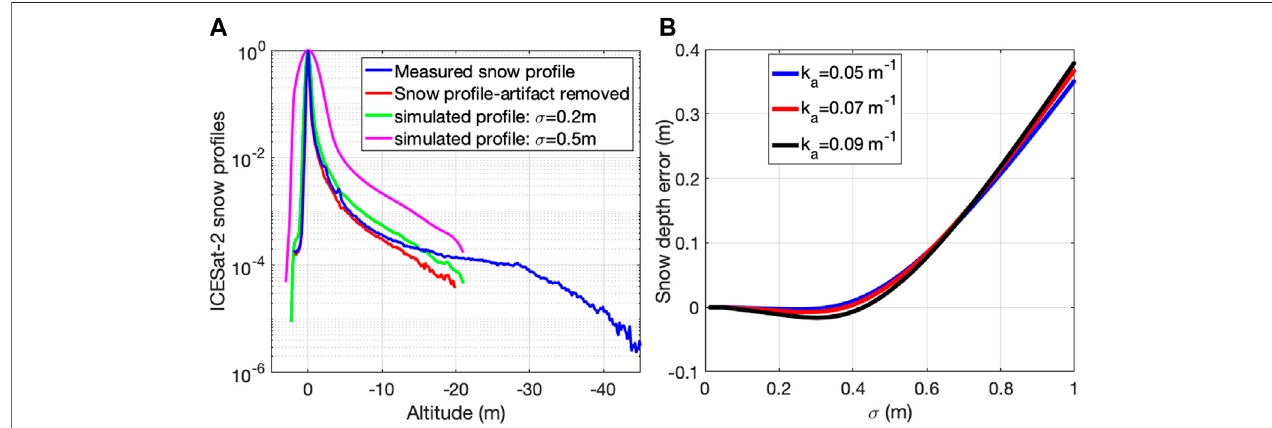
FIGURE 9 | (A) The ICESat-2 snow pro fi le before (blue) and after (red) removing after pulses delays, simulated snow pro fi les with σ = 0.2 m (green) and σ = 0.5 m (pink). (B) Snow depth errors due to the pulse stretching widths with different snow absorption coef fi cients (k a , m − 1 ).